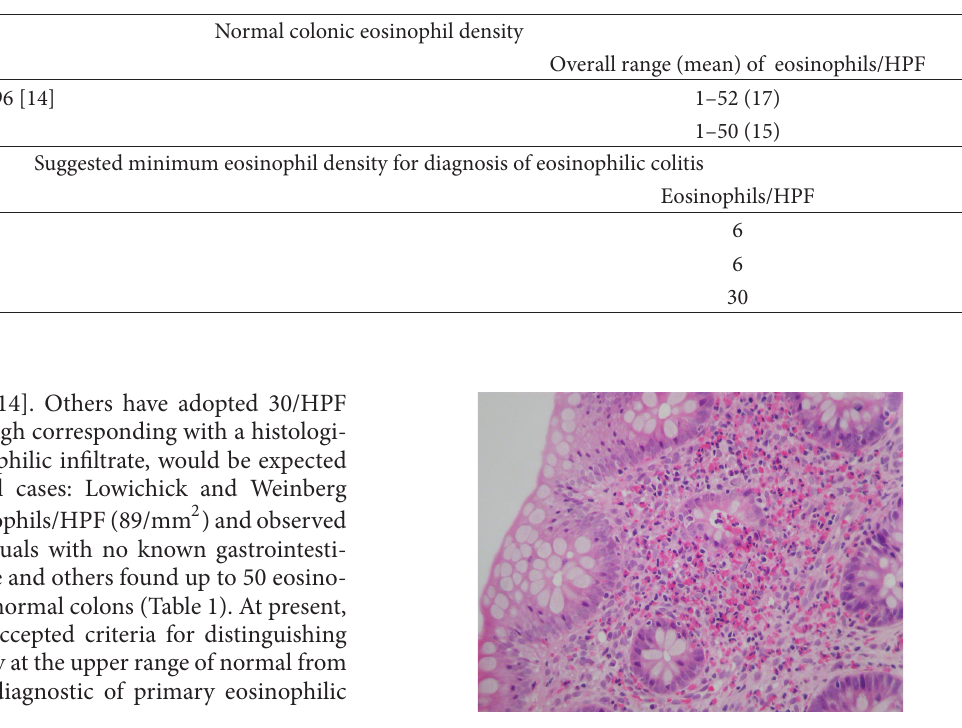
T 1: Eosinophil densities in normal colon and eosinophilic colitis.